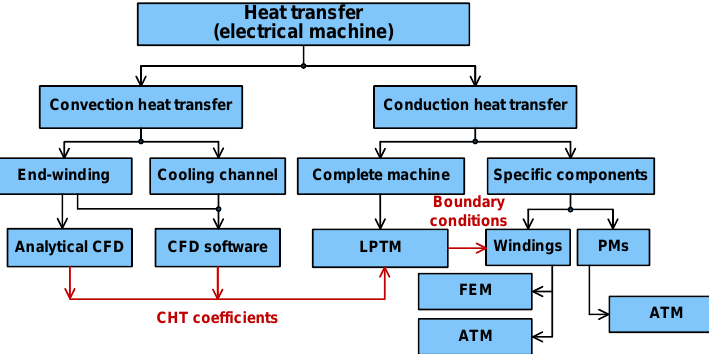
Figure 23. Principle and classification of hybrid thermal model.